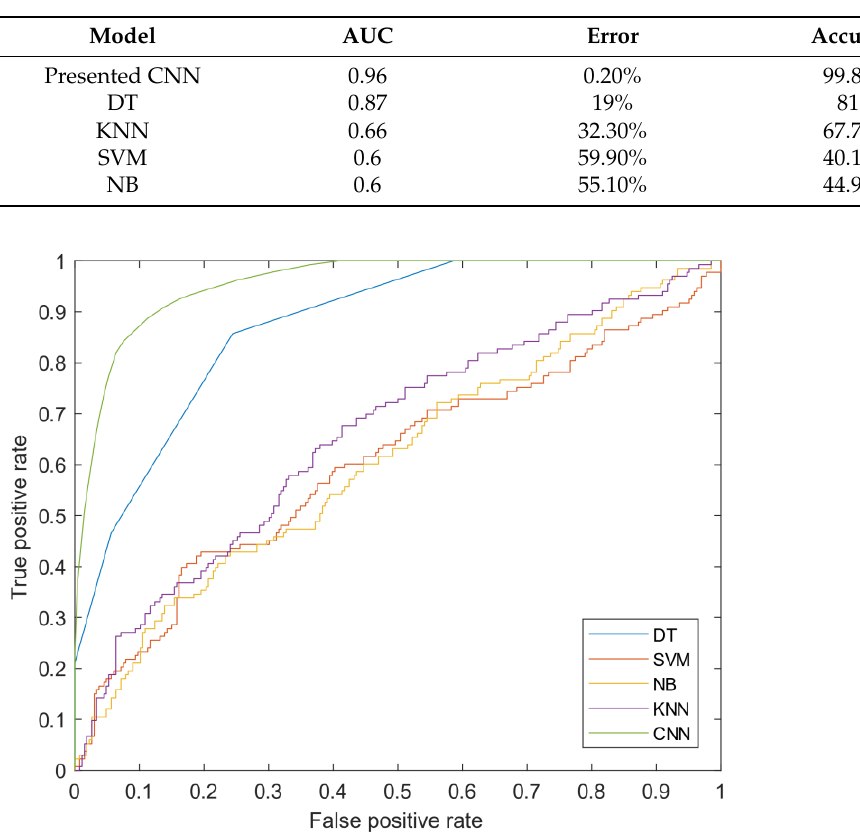
Table 2. Comparison of different classification models.